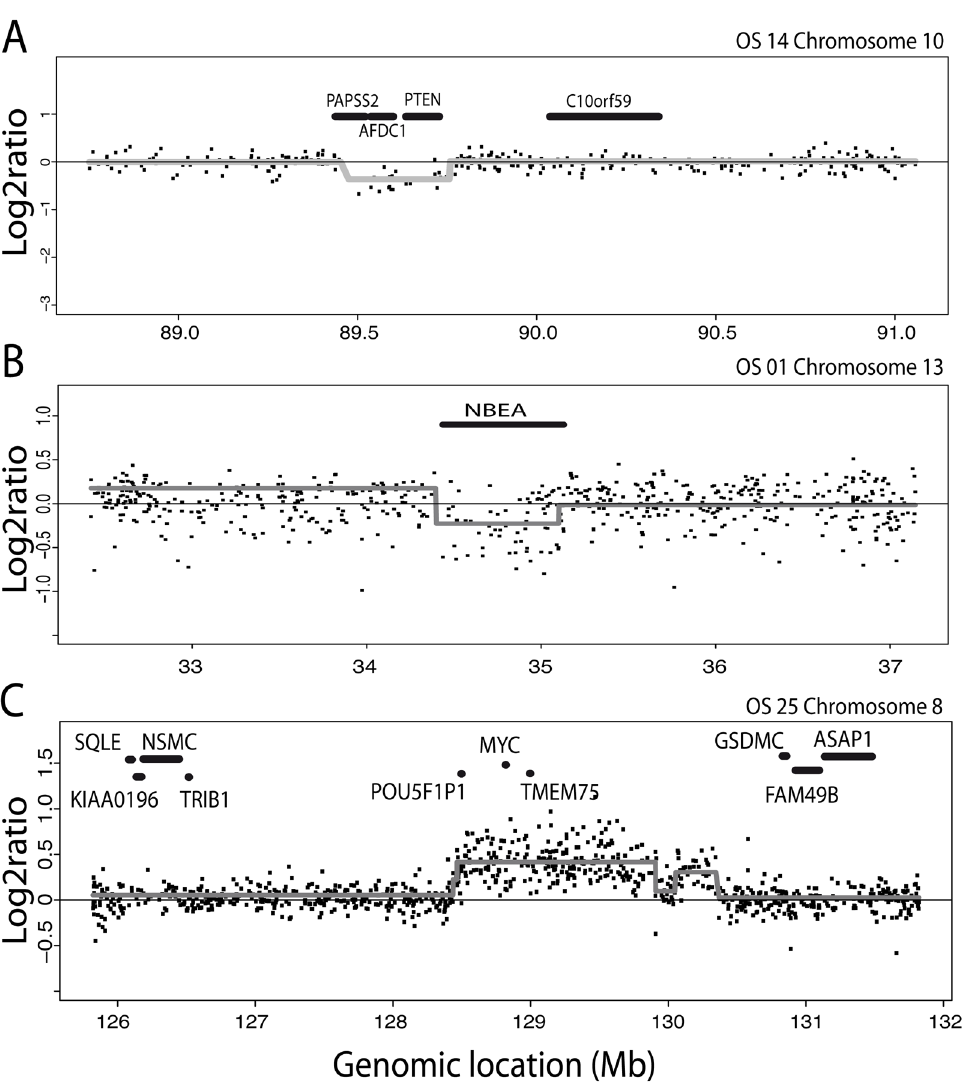
Fig. 2. Representative examples of focal copy number aberrations. Log2ratio for each SNP is plotted against its genomic location. Gray lines indicate segment values as derived using circular binary segmentation (CBS). A, Focal deletion encompassing PAPSS2 , AFDC1 , and PTEN on chromosome 10; B, Focal deletion restricted to NBEA on chromosome 13; C, Focal gain including POU5F1P1 , MYC , and TMEM75 on chromosome